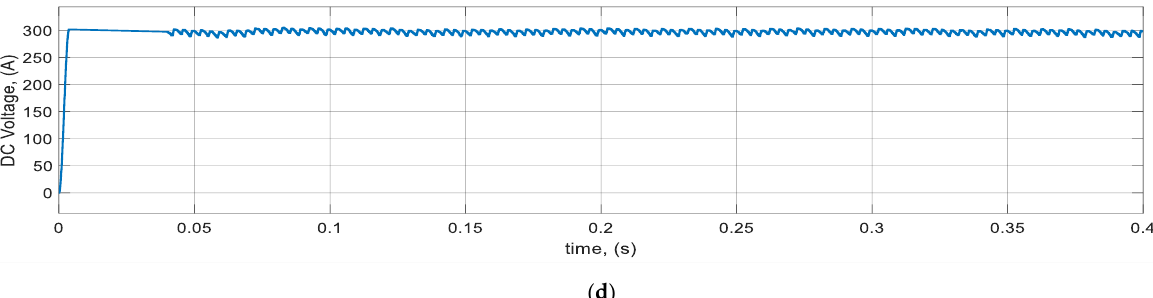
Figure 7. The switching current and DC voltage performance ( a ) the PI controller filtering output current, ( b ) the fuzzy-tuned PI controller filtering current wave shape, ( c ) the shunt capacitor voltage response with PI controller, and ( d ) the shunt capacitor voltage response with fuzzy-tuned PI controller.